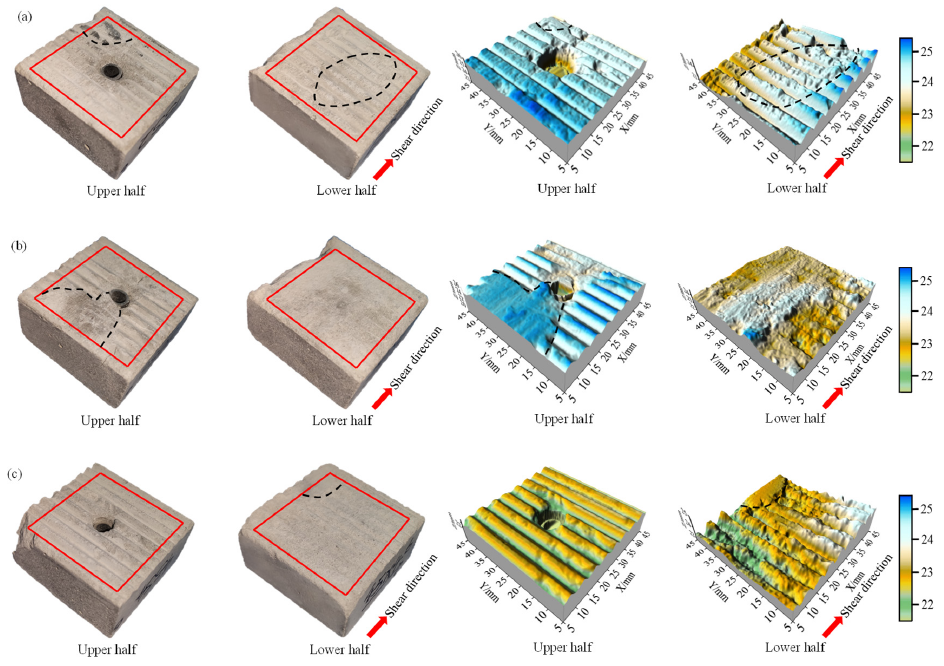
Figure 9. Visual morphology and 3D scans of the structural plane (shear displacement = 25 mm) for ◦ , ( b ) 30 ◦ , and ( c ) 45 ◦ fluctuation angles of ( a ) 15°, ( b ) 30°, and ( c ) 45°. fluctuation angles of ( a ) 15